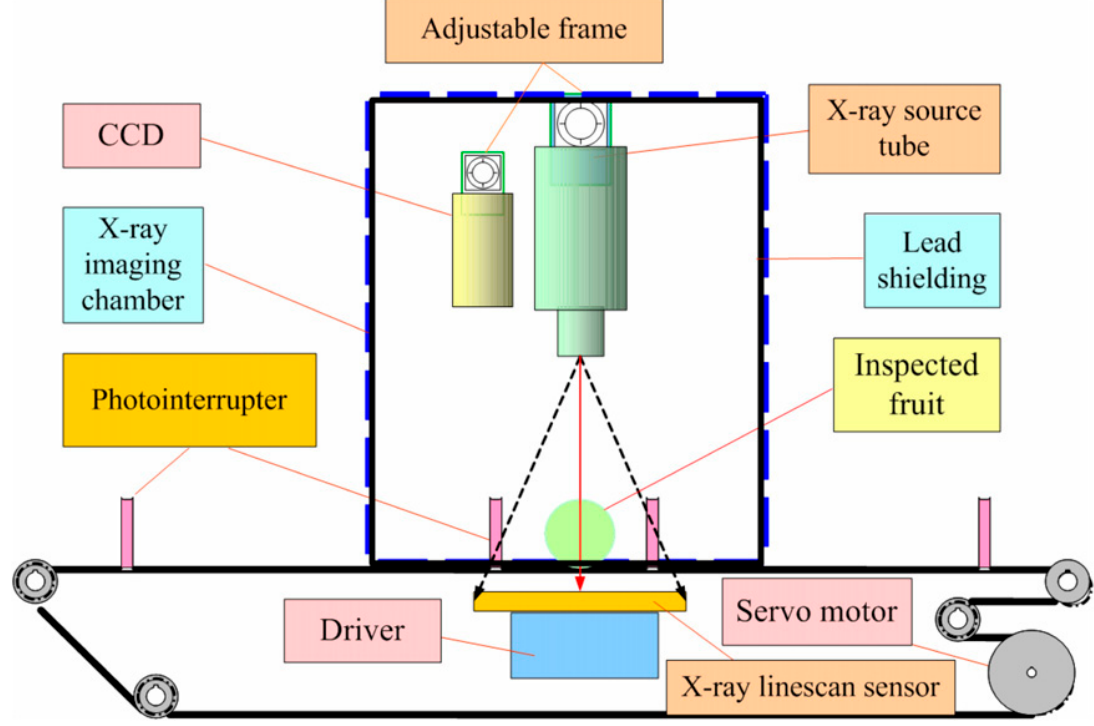
Figure 4. The layout of an X-ray quarantine scanning system [23] .